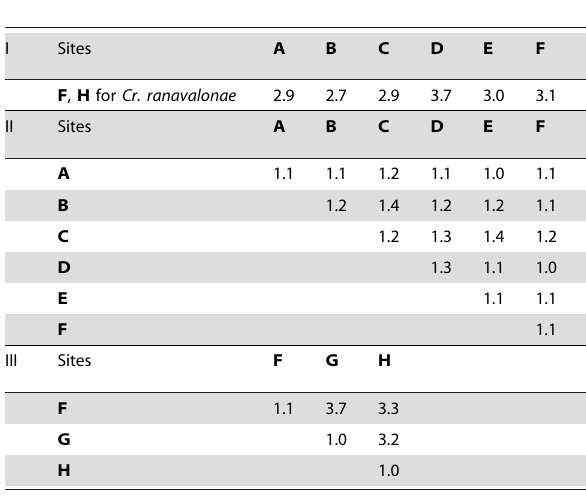
Table 1. Values for aggressiveness during one-on-one confrontations between